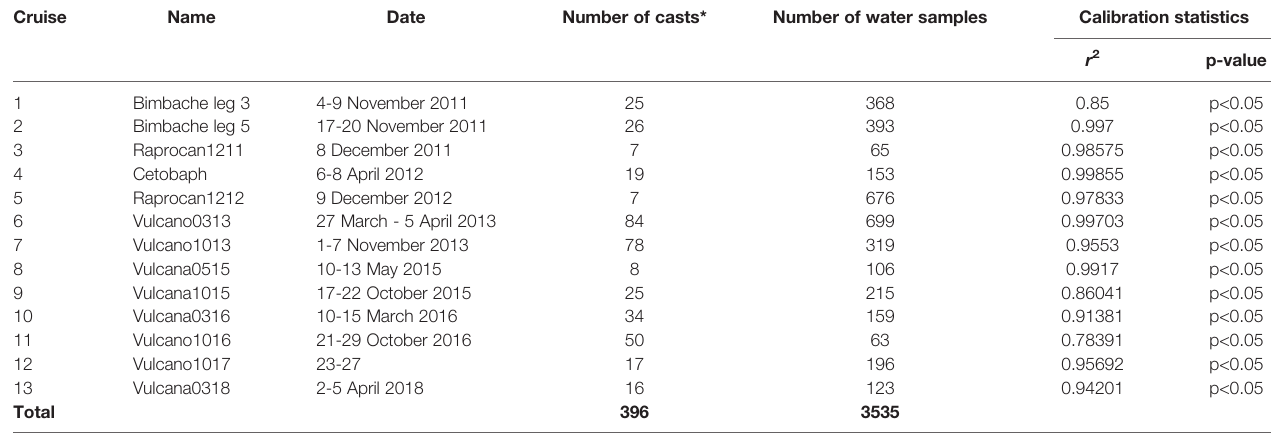
TABLE 1 | Statistics of the calibration of [O 2 ] data from the continuous sensor using water samples analyzed with the Winkler method. Cruise